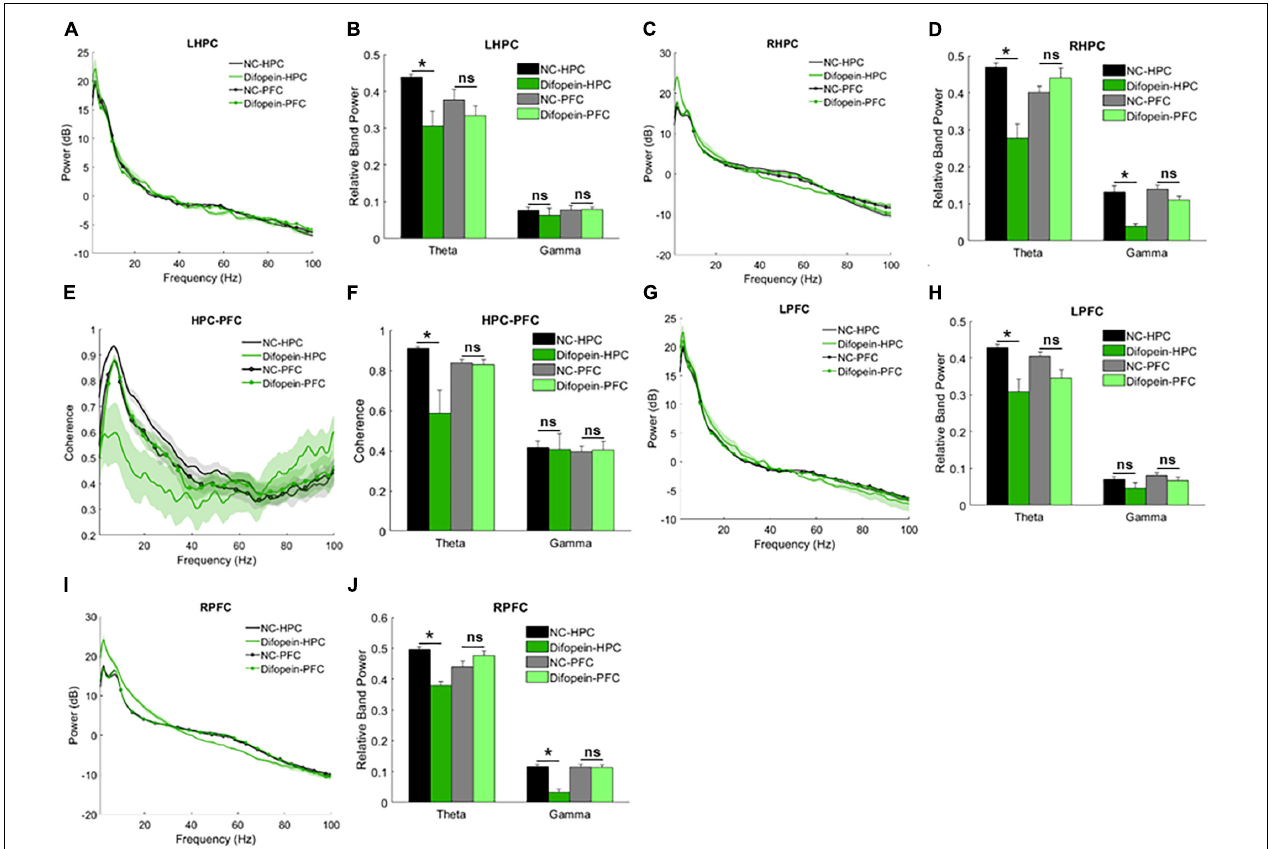
FIGURE 5 | Resting-state power and coherence in WT mice injected with AAV-YFP negative control virus (NC-HPC, n = 7; NC-PFC, n = 10) and AAV-YFP-difopein (Difopein-HPC, n = 5; Difopein-PFC, n = 7). Difopein-HPC but not Difopein-PFC mice display decreased LHPC theta power (A,B) , decreased RHPC theta and gamma power (C,D) , decreased theta coherence between the HPC and PFC (E,F) , decreased LPFC theta power (G,H) , and decreased RPFC theta and gamma power (I,J) . Statistical significance denoted as * p < 0.05. ns , not